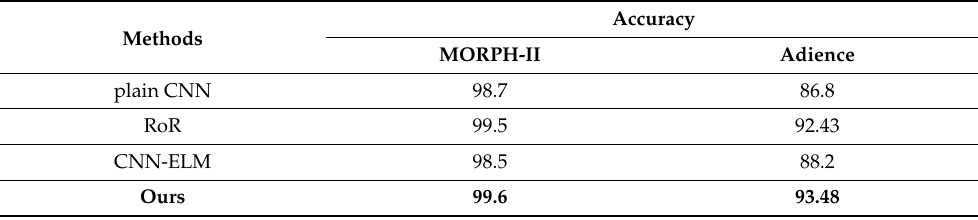
Table 3. Gender estimation accuracy (%) by using different methods based on two datasets.